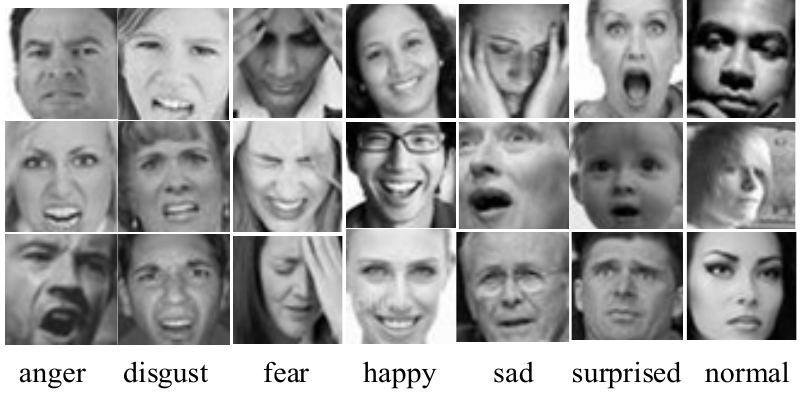
Figure 2. Schematic diagram of the FER2013 dataset.